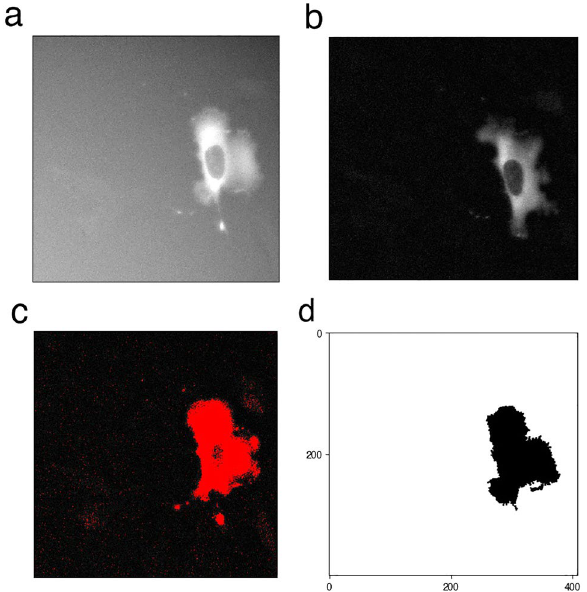
Figure 9. Image processing of motile cells. ( a ) A widefield fluorescence microscopy image of a CHO-K1 cell expressing paxillin-WT-EGFP. Such images often have a light halo and noisy background, that are ( b ) filtered to obtain a high signal-to-noise image, and then ( c ) thresholded to generate a binary image and detect the entire cell body by applying the “find-particle” Fiji/ImageJ plug-in, resulting in ( d ) a binary mask of the cell. For the CPM cell, the binary masks in step d are generated directly without the need for the first three steps a-c because, by definition, the simulated images are binary and have pixels with signal and pixels that have no